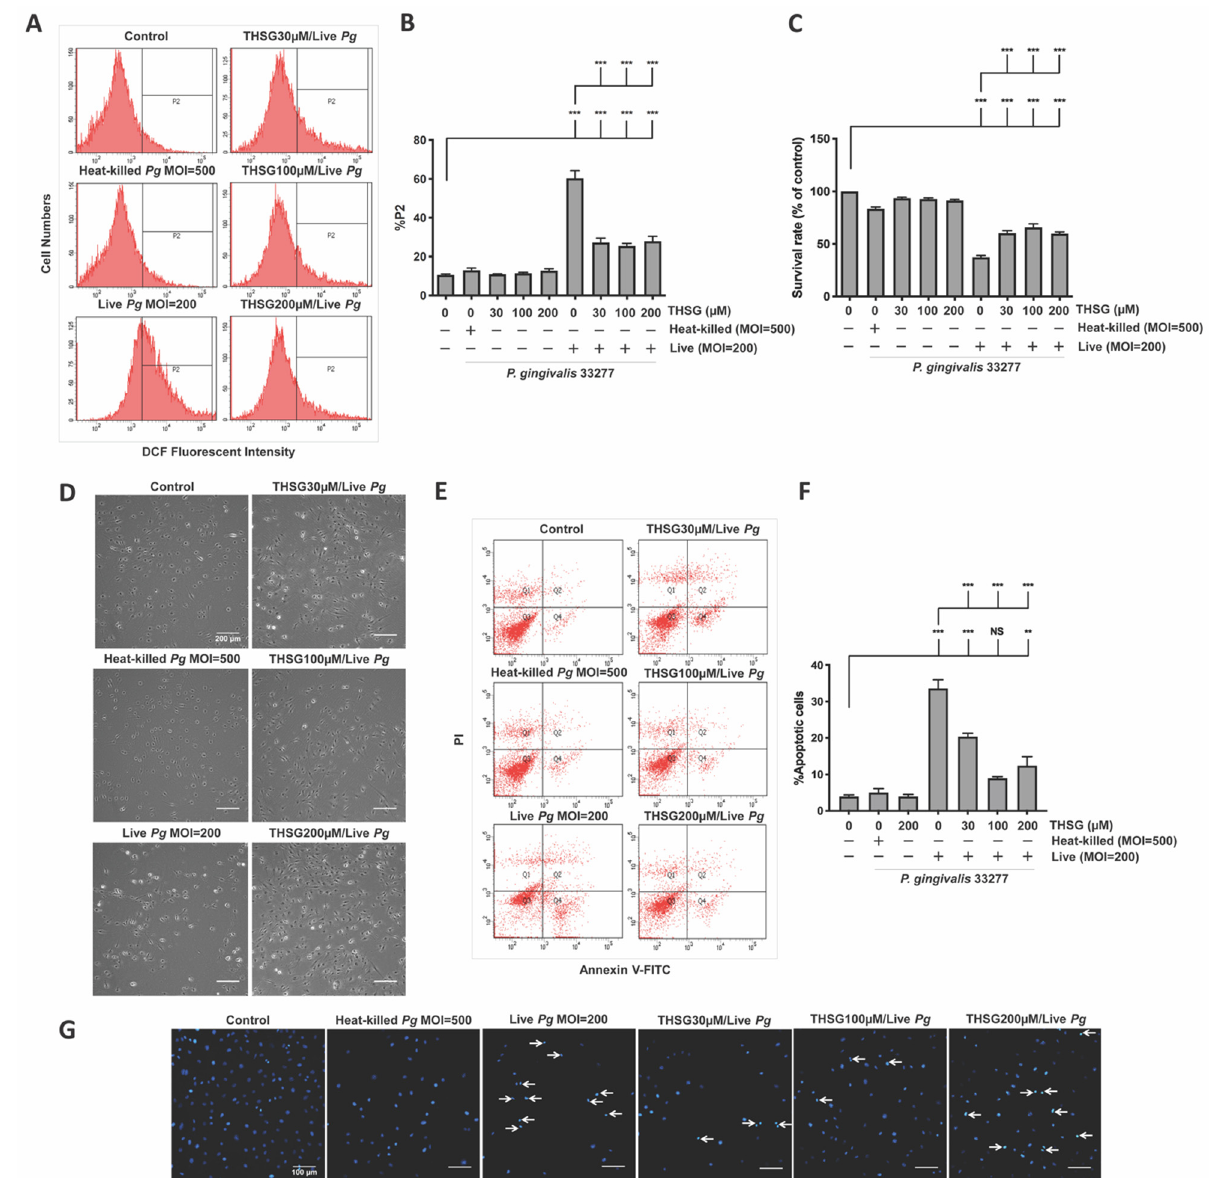
Figure 1. THSG attenuates P. gingivalis -triggered ROS production and cell death in bEnd.3 cells. THSG (0, 30, 100, and 200 μ M) was used to pretreat the cells for 2 h before adding DCFH-DA (50 μ M) for another 30 min. Heat-killed (MOI 500) or live (MOI 200) P. gingivalis were allowed to infect cells for 90 min. The DCF fluorescence intensity (P2 populations) representing ROS production was quantified using a flow cytometer ( A , B ). ( C ) The cell survival rate 24 h post-infection was examined by MTT assay, calculated, and expressed as a percentage of the control. ( D ) The morphology of cells was examined by a light microscope. Scale bar represents 200 µ m. ( E ) Annexin V FITC/PI-stained cells were analyzed using a flow cytometer. The percentage of apoptotic cells is calculated and illustrated in ( F ). ( G ) Cells were stained with DAPI. Nuclear condensation was observed under a fluorescence microscope. Arrows are pointing at cells exhibiting condensed nuclei. Scale bar = 100 µ m. Data are represented as means ± SEM ( n = 4). Significant difference of the control and THSG 0 µ M group are expressed as **, p < 0.01; *** and, p < 0.001. NS: not